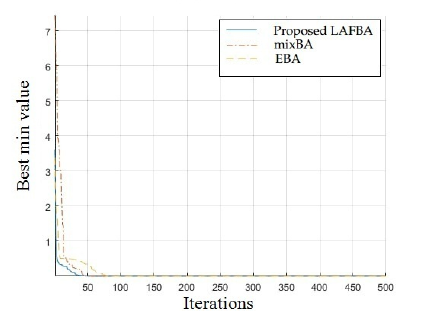
Figure 10. Powell function convergence